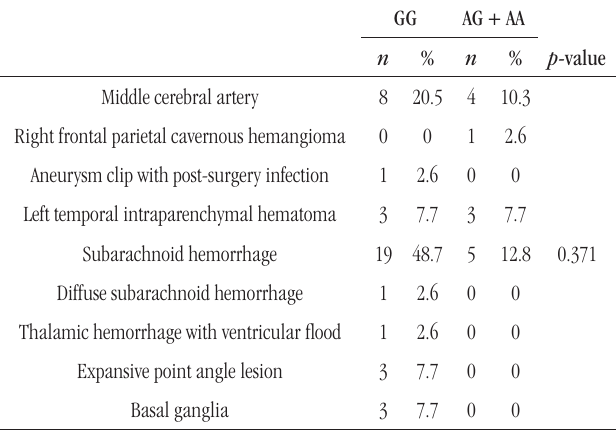
taBLE 6 − Association between TNFA -308G/A (rs1800629) polymorphism genotypes and neuroimaging of case group GG AG + AA